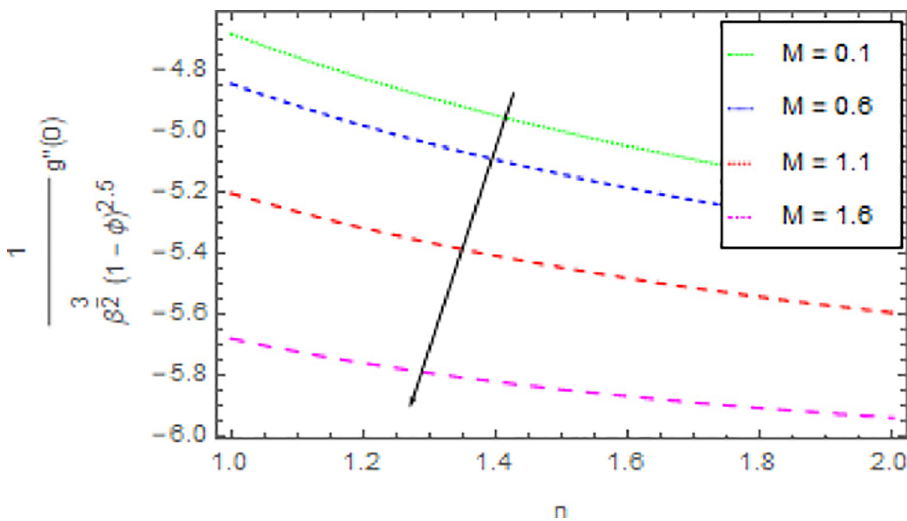
Fig 17. Deviation in skin friction coefficient of velocity ( y − direction) against M and n when Pr = 1000, m = 0.10, δ = 0.40, β = 1.00, Nr = 0.20 and ϕ = 0.01 to ϕ =